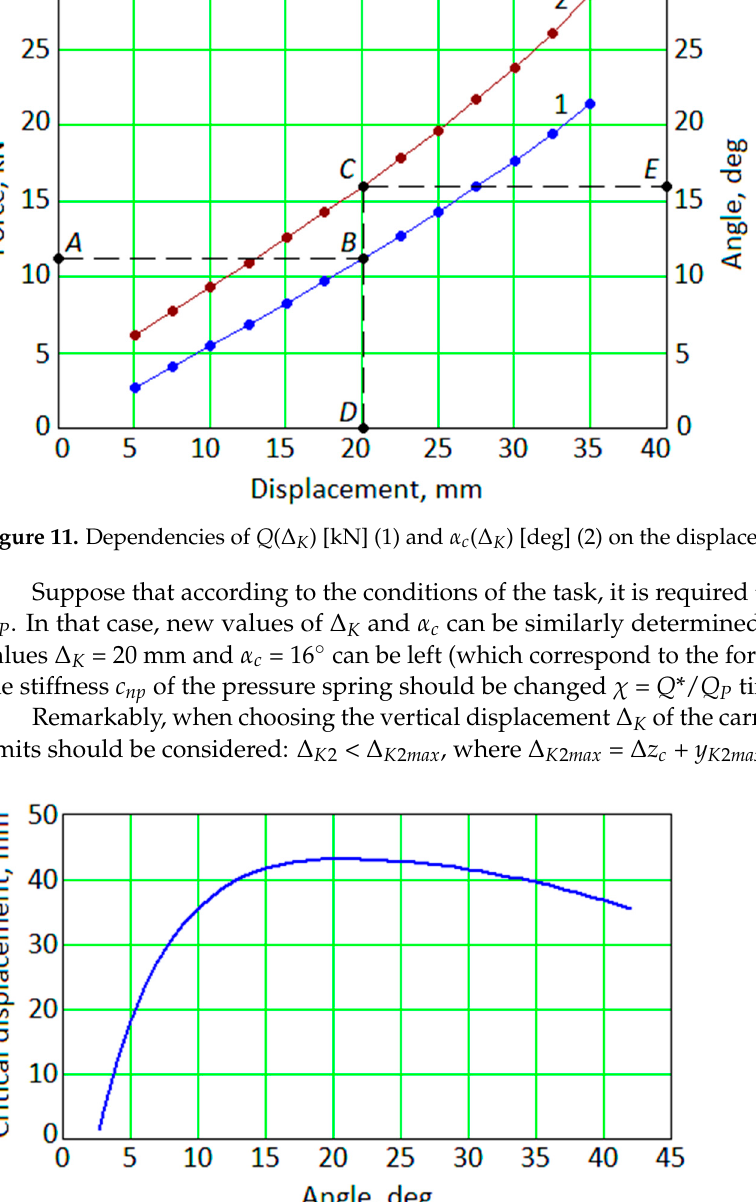
Figure 11. Dependencies of Q ( Δ K ) [kN] (1) and α c ( Δ K ) [deg] (2) on the displacement Δ [mm].